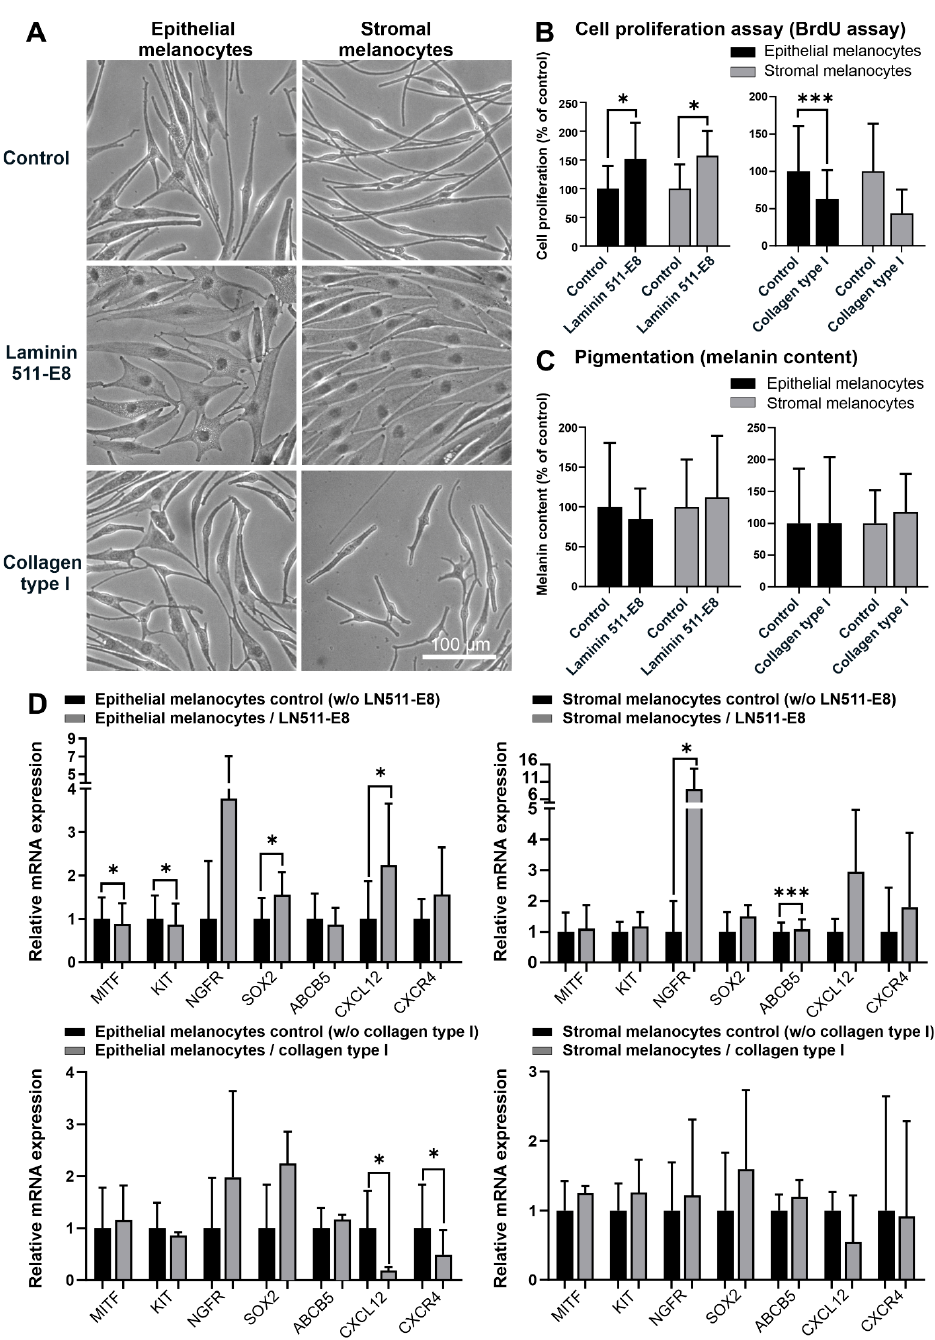
Figure 5. Effects of extracellular matrix components on limbal epithelial and stromal melanocytes. ( A ). Phase-contrast images of limbal epithelial and stromal melanocytes cultured on laminin 511-E8 and collagen type I (the magnification bar at the bottom-right corner applies to all images). ( B ). The effect of laminin 511-E8 and collagen type I on the proliferation of limbal epithelial and stromal melanocytes was analyzed by BrdU incorporation assay after 72 h. Data are expressed as means ± SD ( n = 4) relative to control (* p < 0.05; *** p < 0.001; paired t -test). ( C ). The effect of laminin 511-E8